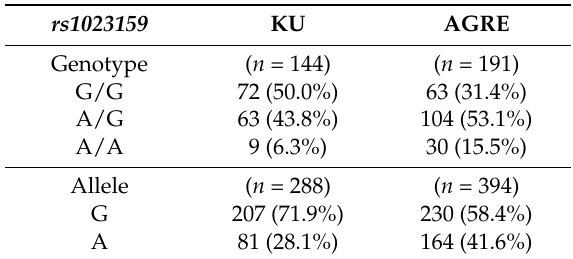
Table 2. Genotype and allele frequencies of rs1023159 in KU samples and AGRE samples for autism spectrum disorder